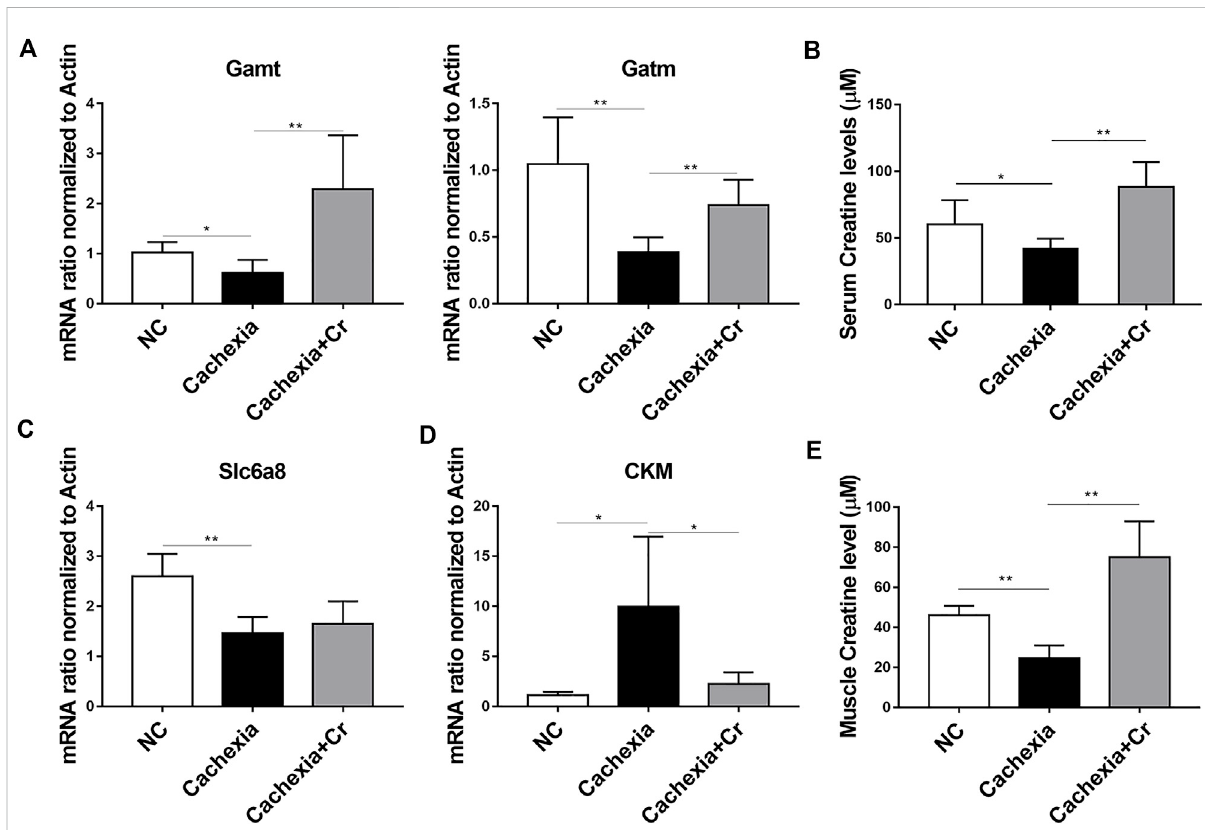
FIGURE 4 Creatine supplementation corrects abnormal creatine metabolism in cachectic mice. (A) Total RNA was extracted from the livers of the three groups,andtheexpressionlevelsofGamtandGatmweremeasuredbyreal-timePCR.* p < 0.05,** p < 0.01. (B) Measurementofcreatinelevelsinthe serum from the NC group, cachexia group and cachexia + Cr group. * p < 0.05 denoted the cachexia group versus the cachexia + Cr group. There was no signi fi cant difference between the NC group and the cachexia group. (C,D) Total RNA was extracted from the gastrocnemius of the three groups, and the expression levels of Slc6a8 and CKM in the gastrocnemius were measured by real-time PCR. * p < 0.05, ** p < 0.01. (E) Measurementofcreatinelevels inthemusclefrom theNCgroup, cachexiagroup and cachexia+ Crgroup. ** p < 0.01 denotedtheNCgroup versus the cachexia group. ** p < 0.01 denoted the cachexia group versus the cachexia + Cr group. Data are expressed as the mean ±